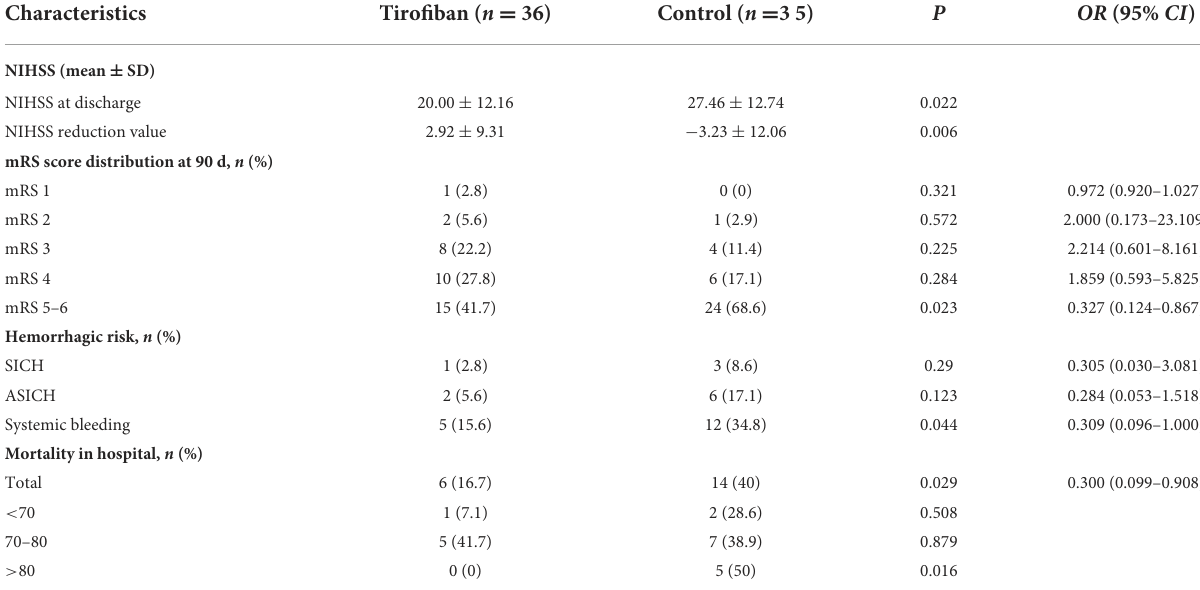
TABLE 2 Efficacy and safety outcomes.